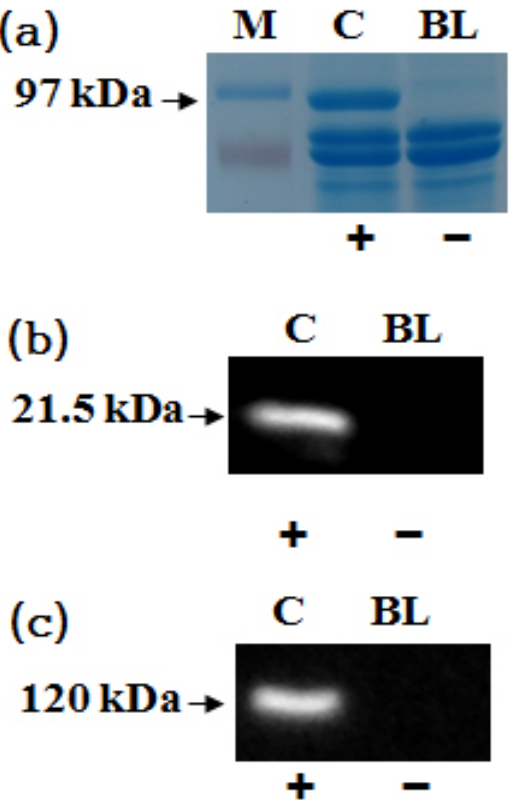
Figure 2. Determination of lipoxygenase protein ( a ), Kunitz trypsin inhibitor (KTI) protein ( b ), and lectin protein ( c ). M, marker; C, ‘Chungja#3’ ( Lox1Lox2Lox3 / Lox1Lox2Lox3 - Ti / Ti - Le / Le - RS2 / RS2 ); BL, tetra null line ( lox1lox2lox3 / lox1lox2lox3 - ti / ti - le / le - rs2 /rs2). +, − : presence and absence of lipoxygenase, KTI, and lectin proteins, respectively. Proteins of lipoxygenase, KTI, and lectin were not observed in the mature F 5 seed of the breeding line (BL). However, these three proteins were observed in the seed of the ‘Chungja#3’ ( Lox1Lox2Lox3 / Lox1Lox2Lox3 - Ti / Ti - Le / Le - RS2 / RS2 ) cultivar.